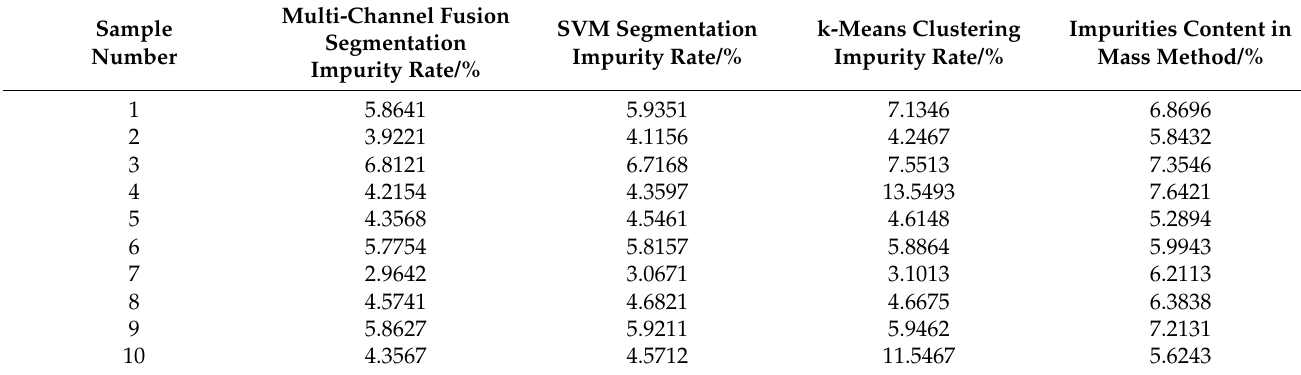
Table 2. Impurity contents of machine-picked seed cotton based on image information and the mass